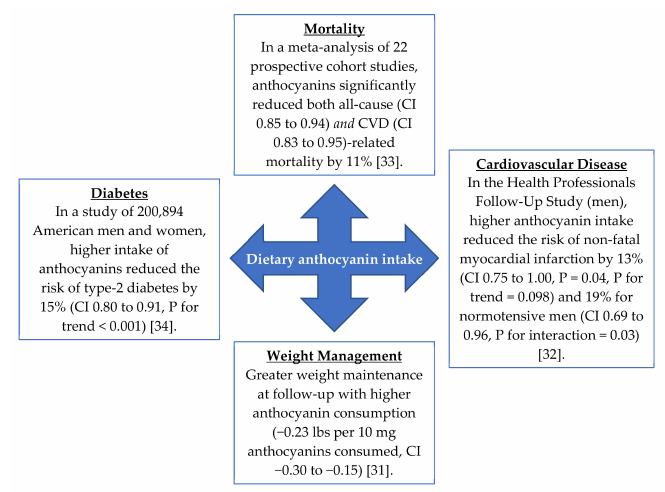
Figure 2. Anthocyanin consumption protects against age-related chronic diseases. CI; 95% confidence